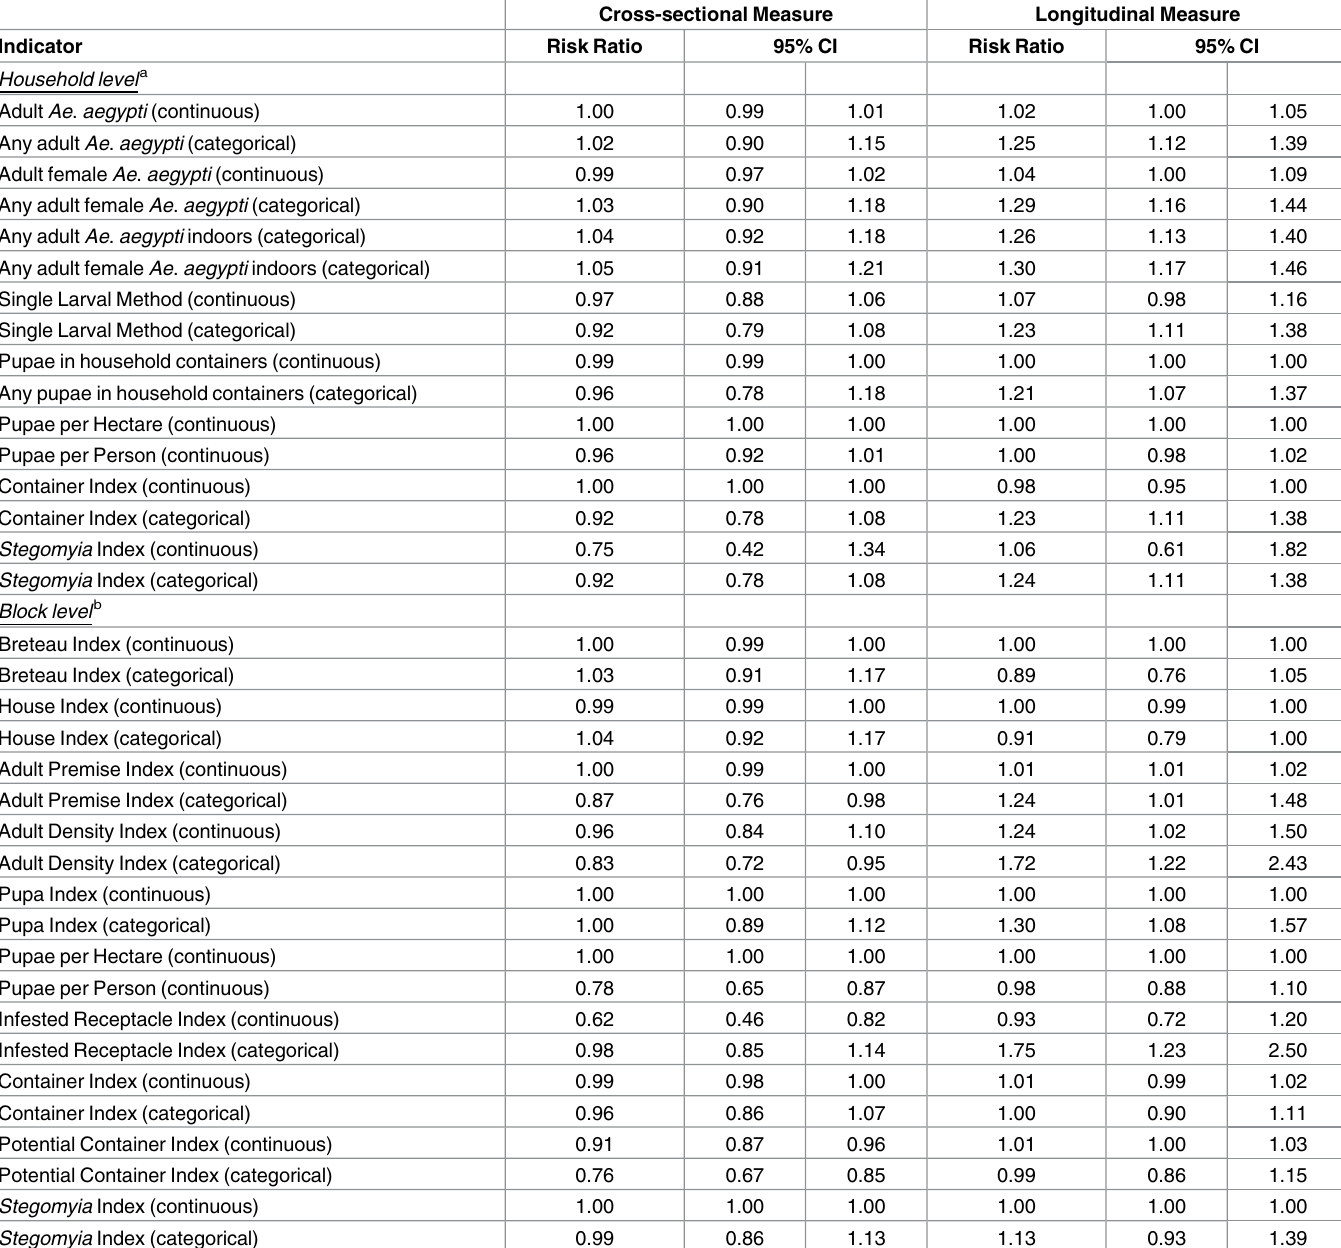
Table 5. Adjusted risk ratios: association between Ae . aegypti and DENV seroconversion Cross-sectional Measure Longitudinal